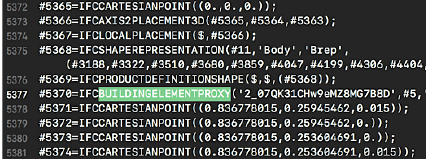
Figure 7. IFC entity of line 5377 classified as “ifcbuildingelementproxy”